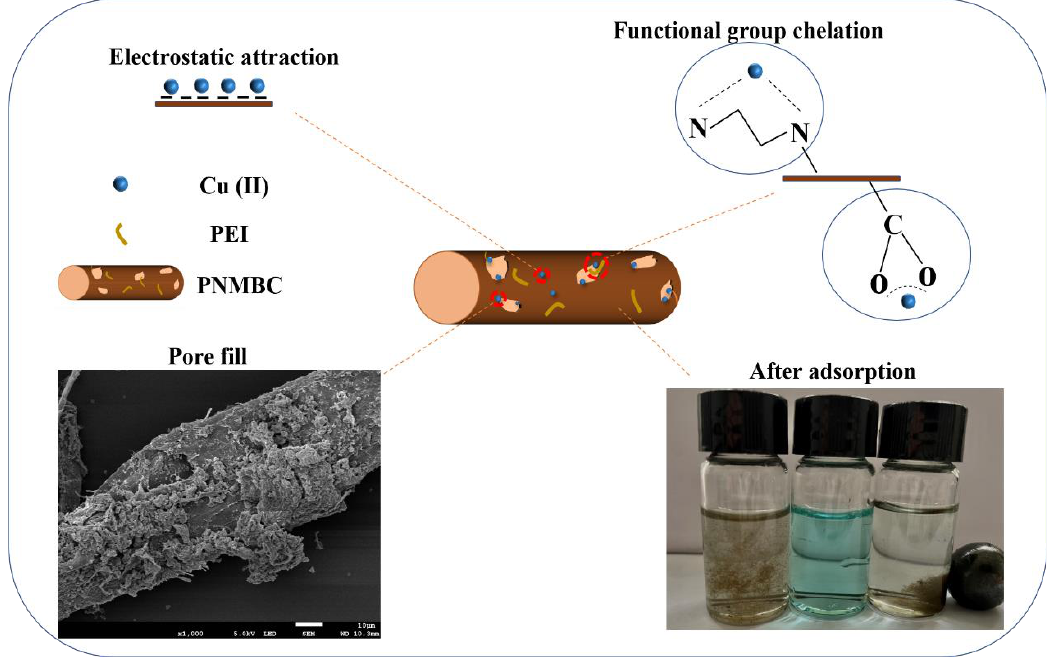
Figure 13. Mechanism of Cu( Ⅱ ) adsorption by the PNMBC biosorbent.